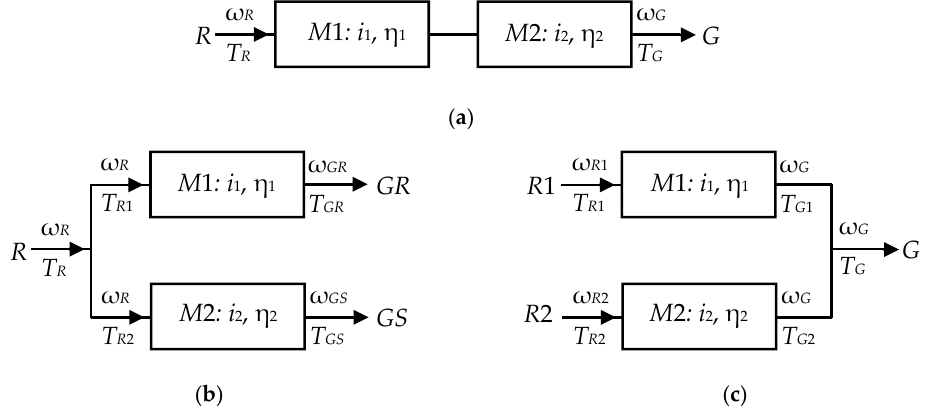
Figure 2. Block diagrams of 1-DOF speed increasers with two 1-DOF mechanisms M 1 and M 2, having: ( a ) one rotor and one standard electric generator; ( b ) one rotor and counter-rotating electric generator; ( c ) two counter-rotating input rotors with standard electric generator. R , R 1 and R 2 are wind or water rotors, G and GR are the electric-generator rotor; GS is the electric generator stator; T x is the torque transmitted and ω x is the angular velocity of shaft x ; and i 1 and i 2 are the kinematic ratios and η 1 and η 2 are the efficiencies of constituent mechanisms M 1 and M 2 .